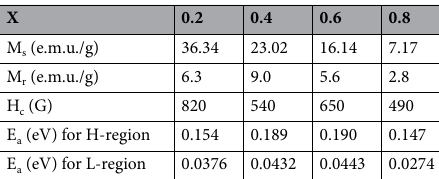
Table 2. The magnetic and activation energy parameters of SLFO